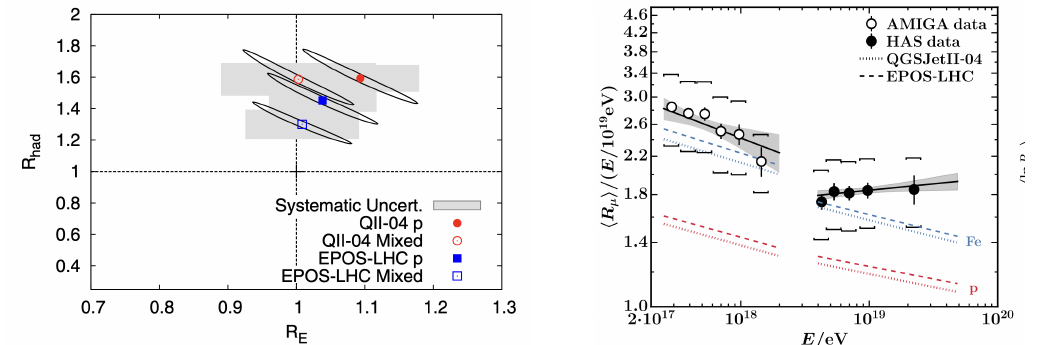
Figure 1: Left: Rescaling factors for the simulated hadronic signal R mary energy R for two hadronic interaction models considering alternatively a pure E proton composition and a mixed proton-iron composition. The grey rectangles indi- cate the systematic uncertainties. [ 5 ] . Right: Energy evolution of the average muon content as measured with the UMD (white circles) and with the SD (black circles). Predictions for proton and iron primaries for two hadronic interaction models are also shown. [ 6